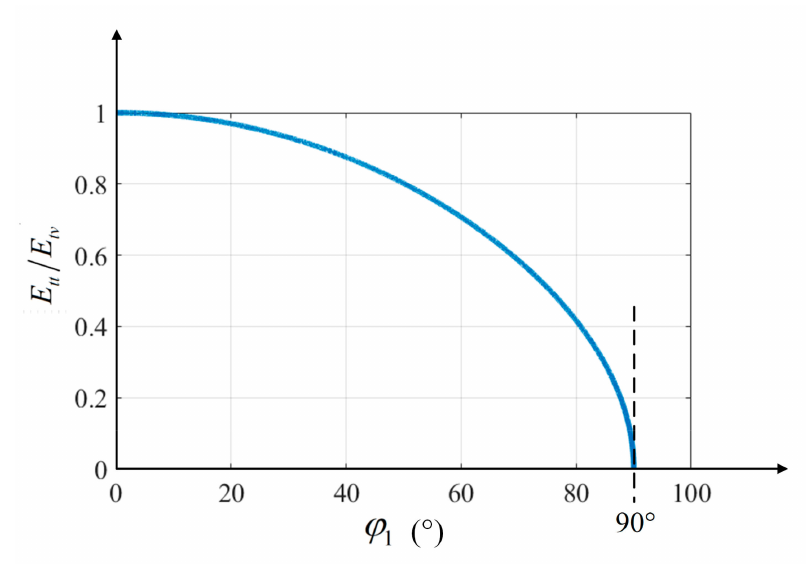
Figure 3. The radio of E tt and E tv with ϕ 1